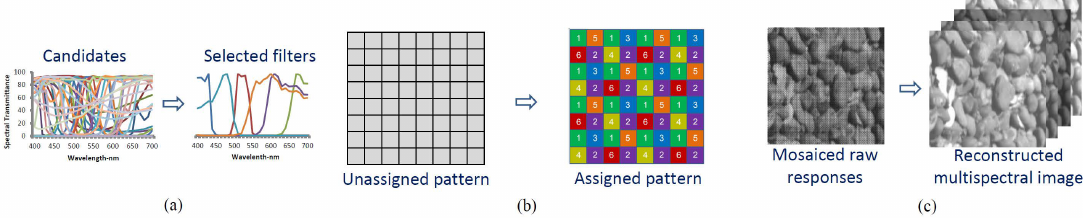
Figure 1. Three mutually dependent issues in MSFA design. ( a ) Selecting the used filters from commercial candidate filter set; ( b ) Assigning the selected channels on Multispectral filter array (MSFA) pattern; ( c ) Spectral reconstruction from mosaiced raw response images to reconstructed multispectral